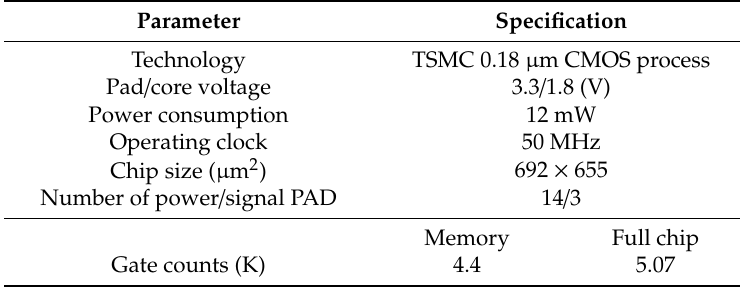
Table 3. Chip specification.